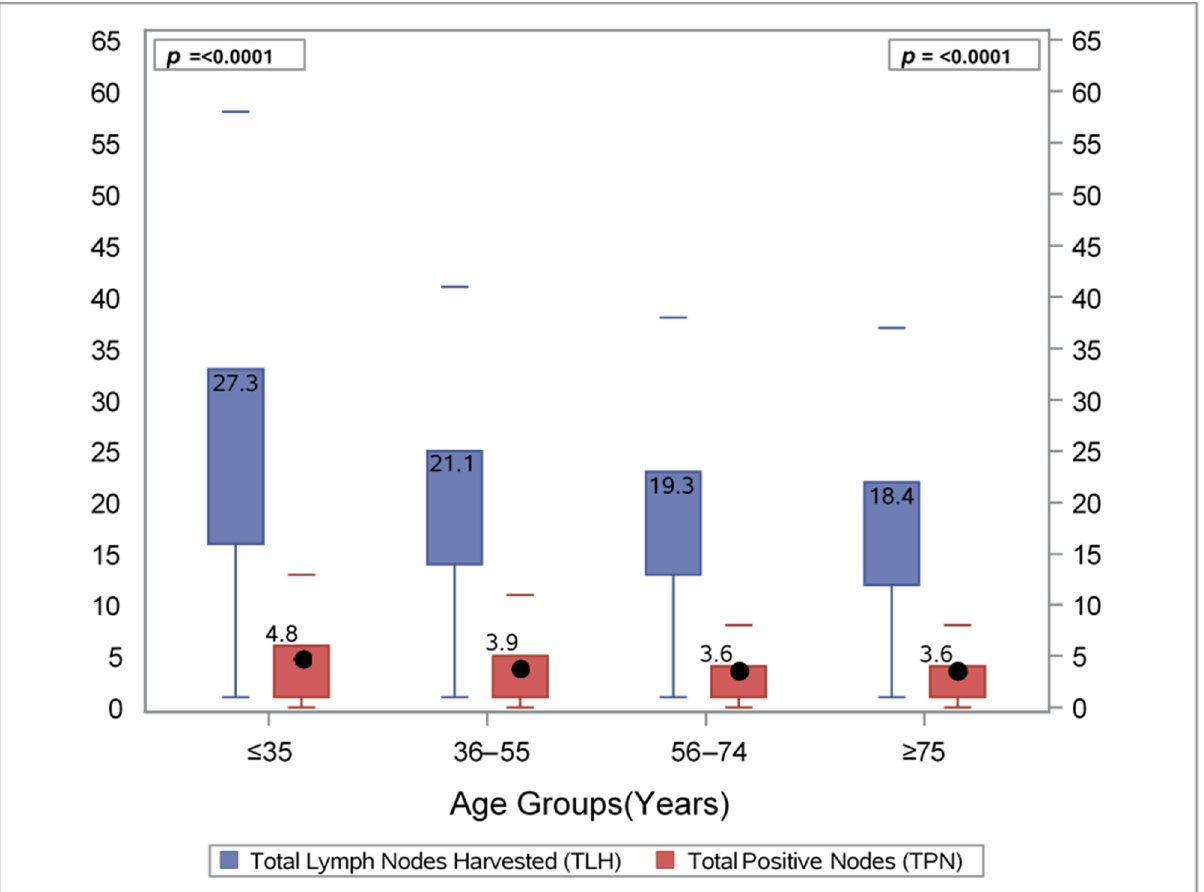
Figure 1. Mean total lymph nodes harvested (TLH) and total positive nodes (TPN) by age groups with at least one lymph node harvested.